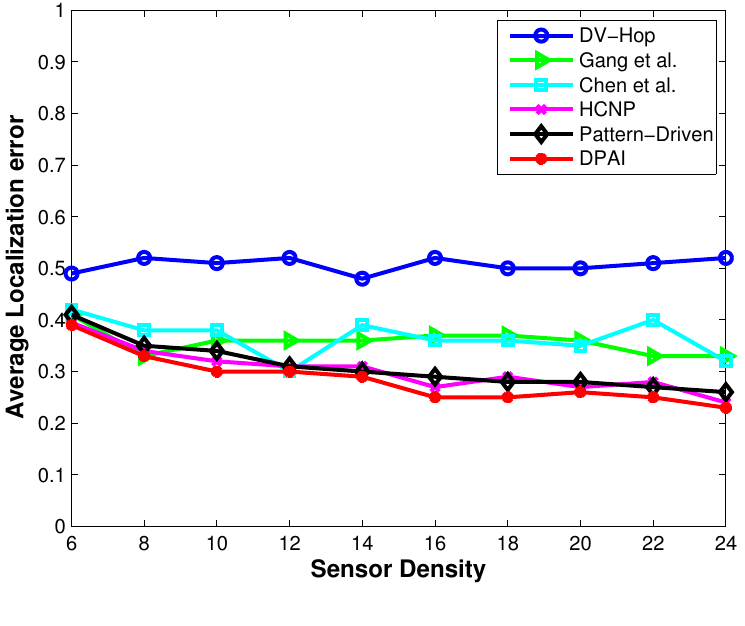
Figure 5. Localization error vs . sensor density (Isotropic